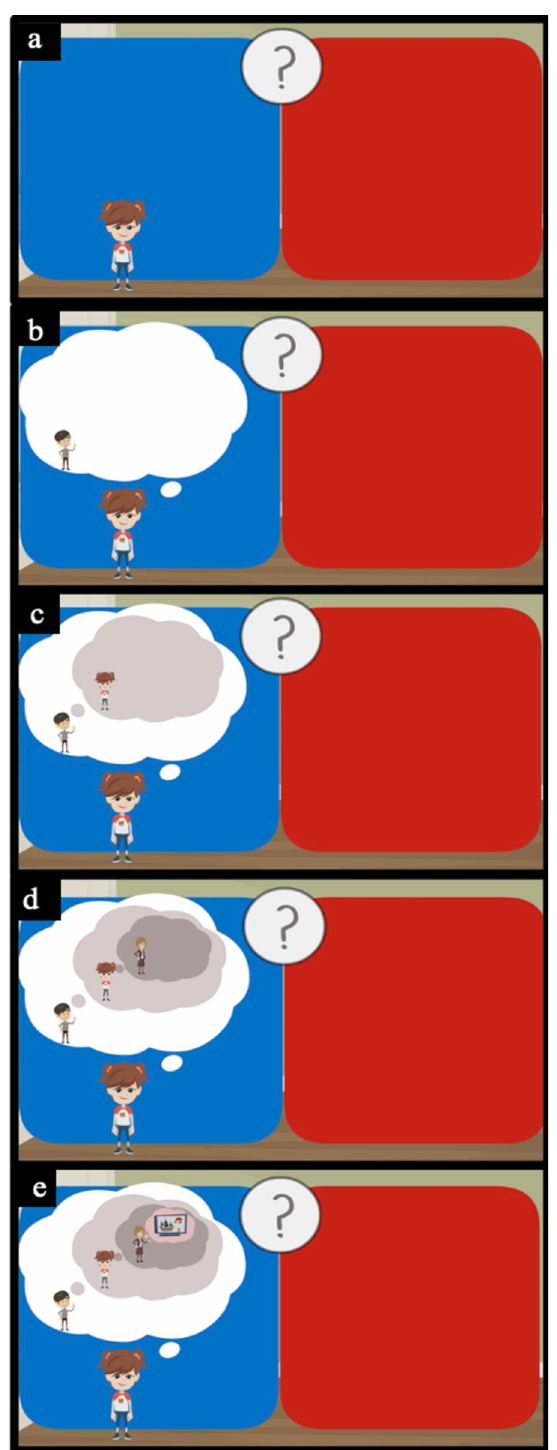
Fig 2. Screenshots of the visual animation of the fourth-order Theory of Mind test question in the story line “the video dilemma”. Note . Children heard a voice slowly reading out the answer sentences while the animation was presented accordingly on the screen. E.g., “Sarah hopes [picture a] that Olli believes [picture b] that she knows [picture c] that Mrs. Brown wants [picture d] them to watch a pirate film [picture e]”. After that the second answer option (red side) was read out and presented